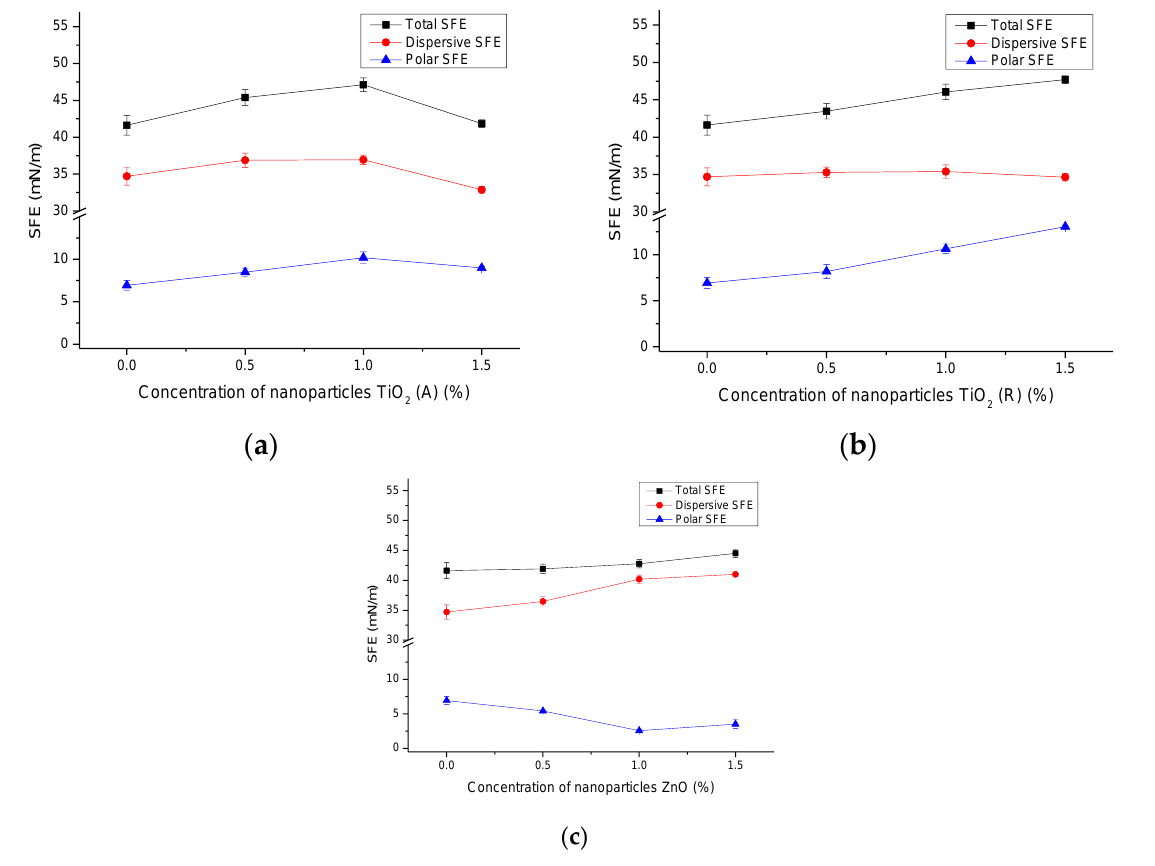
Figure 3. SFE of uncoated paperboards with deposited ink films without and with the addition of nanoparticles; ( a ) TiO 2 (A), ( b ) TiO 2 (R), and ( c ) ZnO.